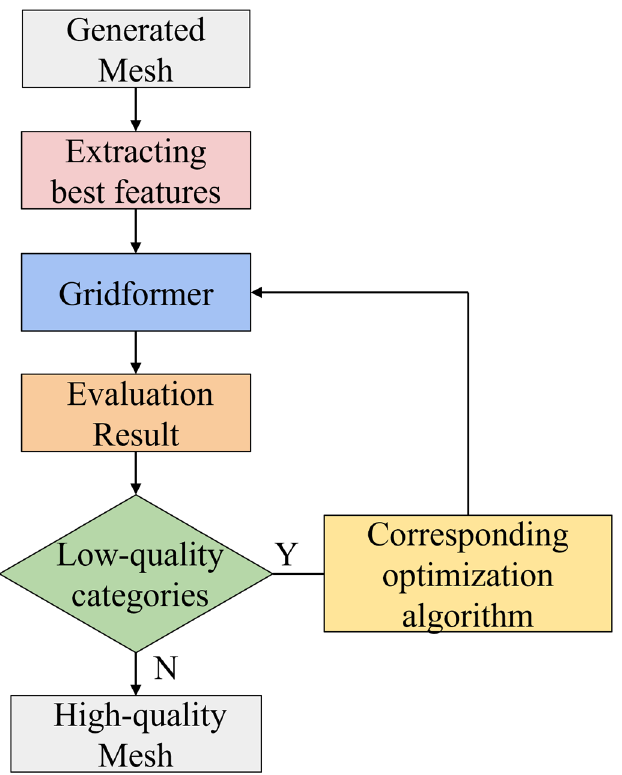
Figure 17. Workflow for automatic generation of high-quality meshes based on Gridformer.